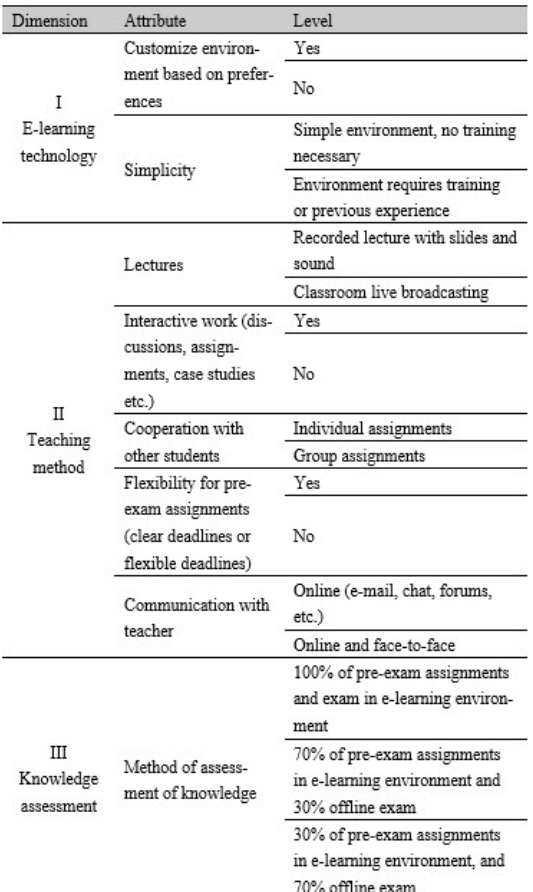
Table 1. Student satisfaction with